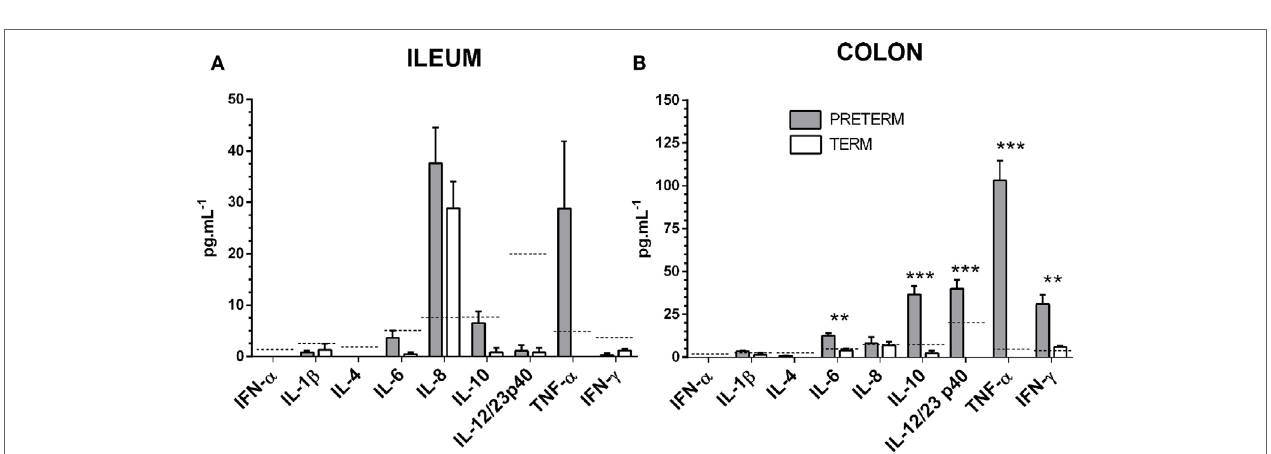
FigUre 6 | Inflammatory cytokines in the ileum and the colon. Levels of interferon/chemokine/cytokines in the ileum (a) and the colon (B) of the preterm ( n = 10, gray columns) and the term ( n = 6, white columns) piglets were compared. The values in the both the ileum and the colon were comparable or higher in the preterm piglets, but the statistically significant differences were found in the colon only. The results are presented as mean + SEM. The statistical significances in the colon are denoted with asterisks (** P < 0.01 and *** P < 0.001). Dashed lines indicate individual cytokine detection limits.